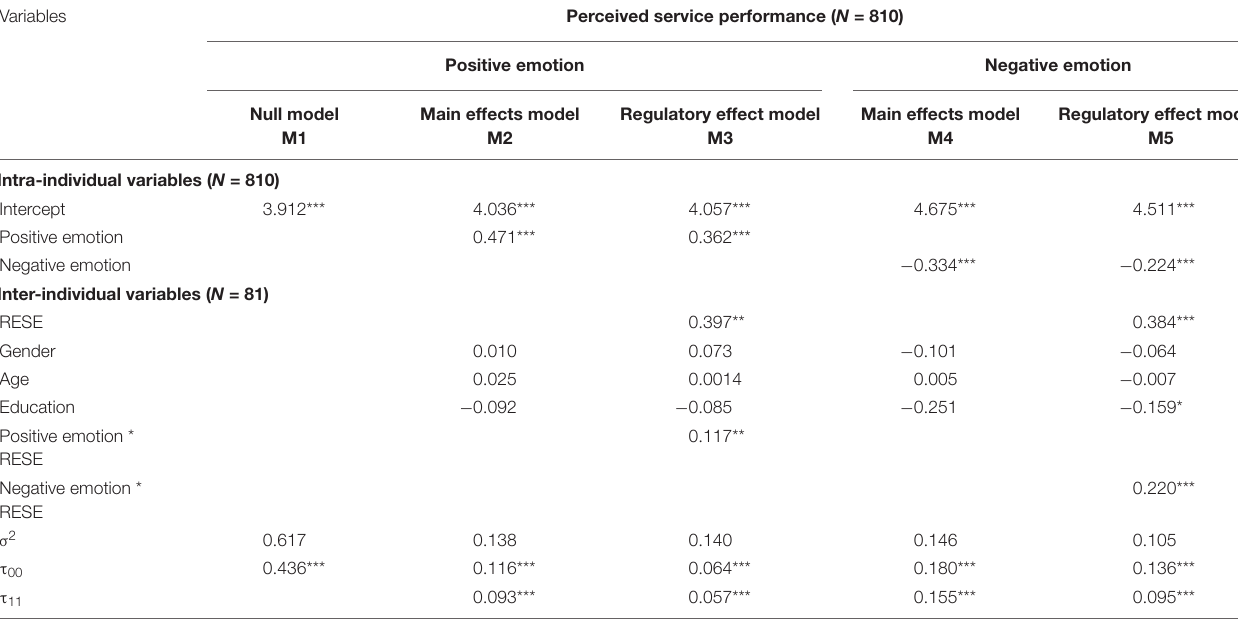
TABLE 3 | Multilevel analyses: Perceived service performance by daily emotion fluctuations and RESE. Variables